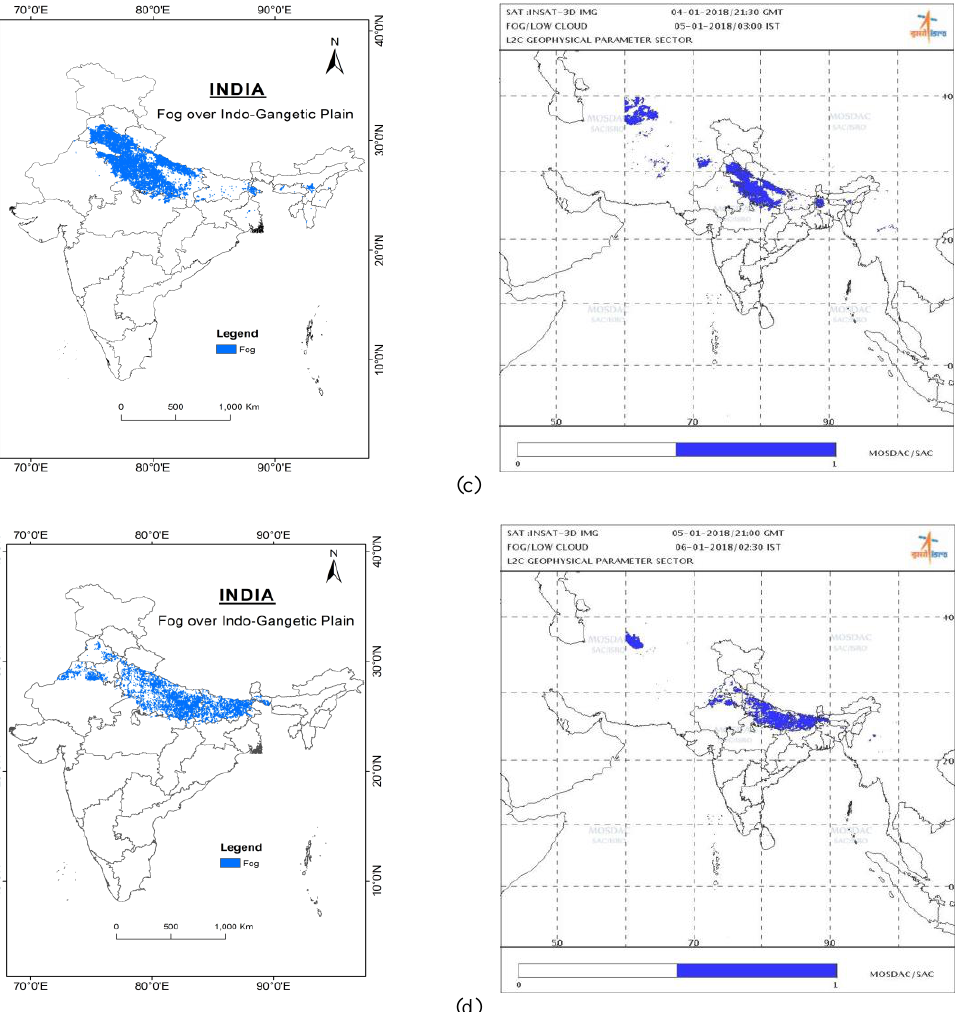
Figure 5. Fog maps and INSAT-3D imager Level-2C products for (a) 02 January 2018 (2100 UTC/0230 IST), (b) 03 January 2018 (2100 UTC/0230 IST), (c) 04 January 2018 (2100 UTC/0230 IST), and (d) 05 January 2018 (2100 UTC /0230